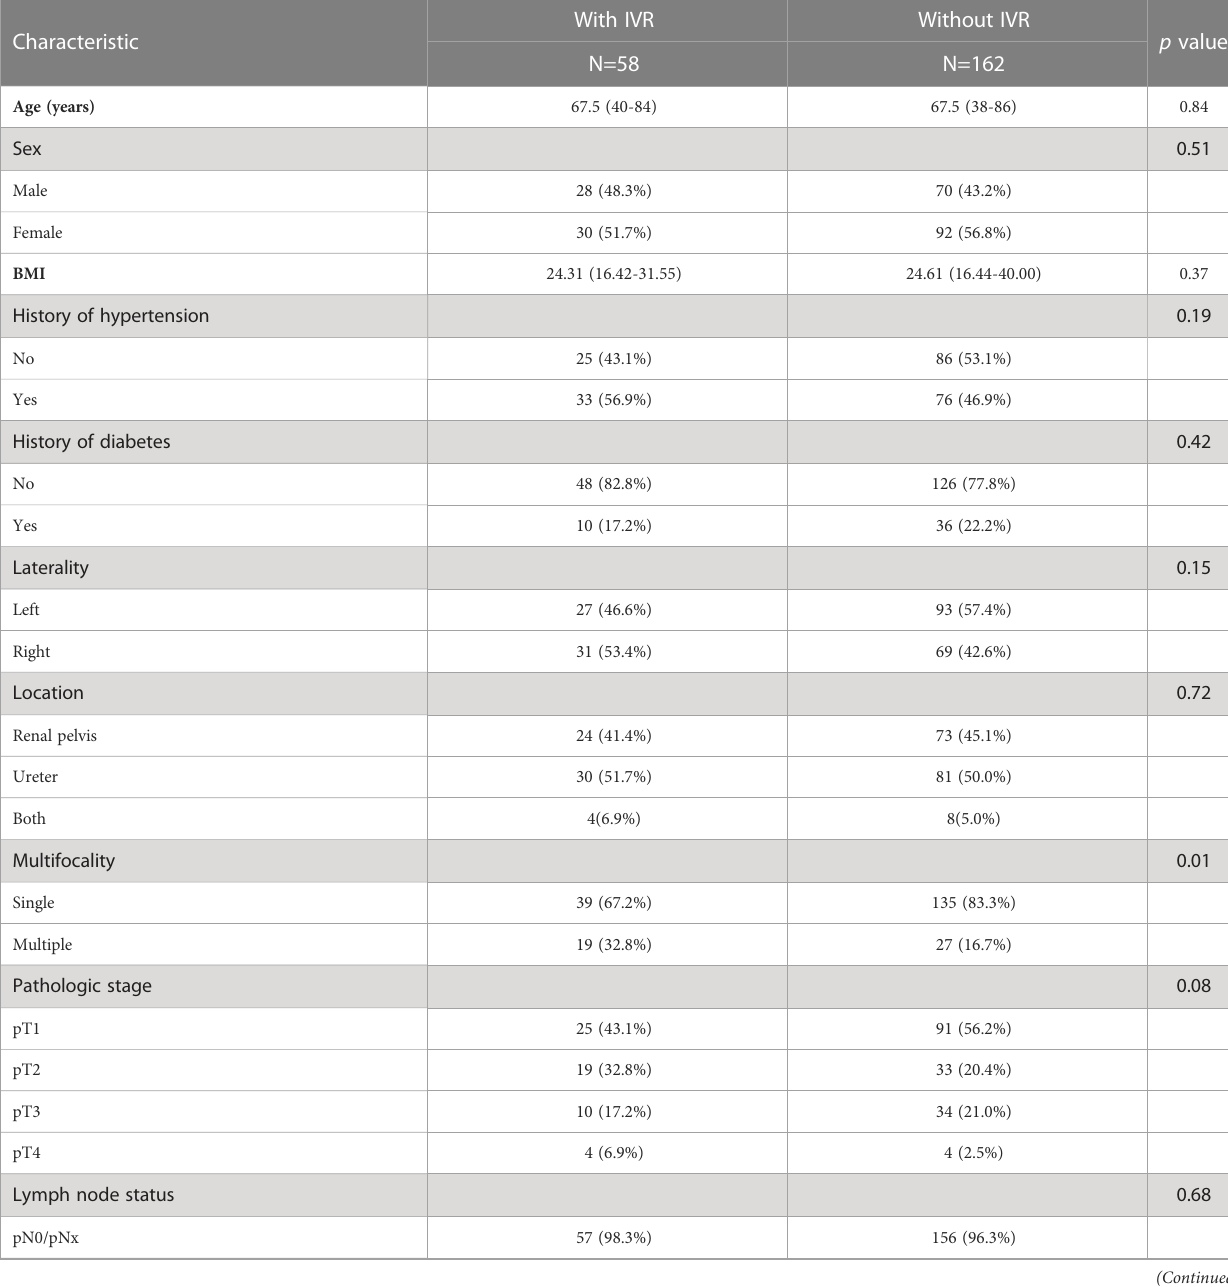
TABLE 2 Association between clinicopathologic features and IVR in UTUC.